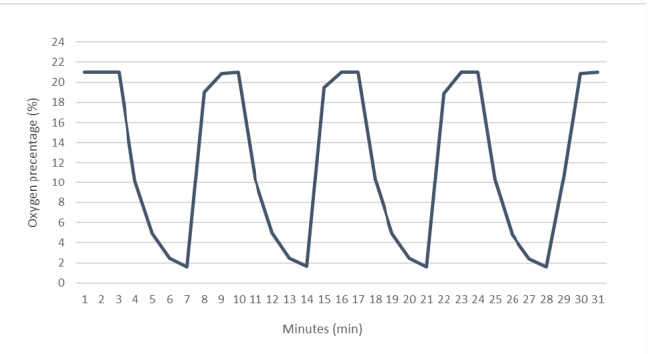
Figure 5. Representative intermittent Hypoxia data measured during a real-time experiment in the OxyCycler incubator chamber. Measurements were collected every 2 s and compressed for repre- sentation.